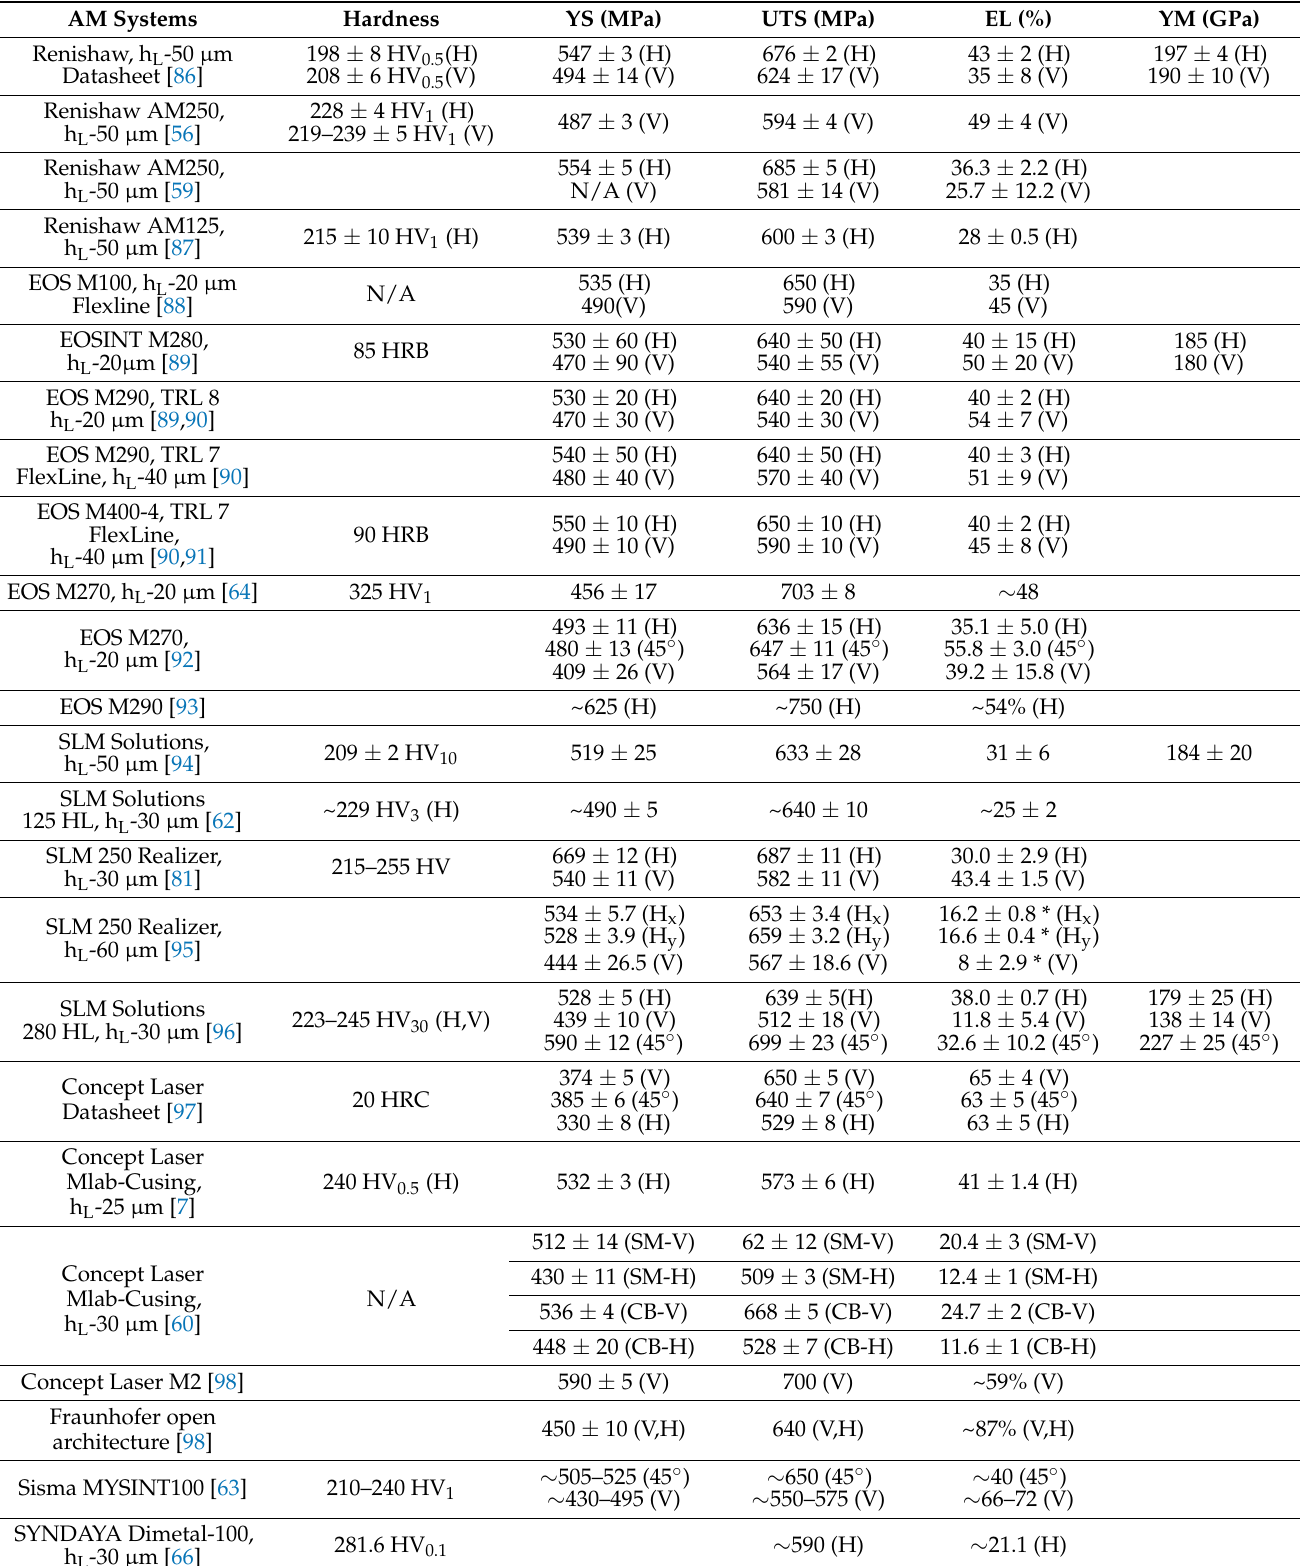
Table 5. As-built, room temperature properties of 316LSS using stand-alone LPB